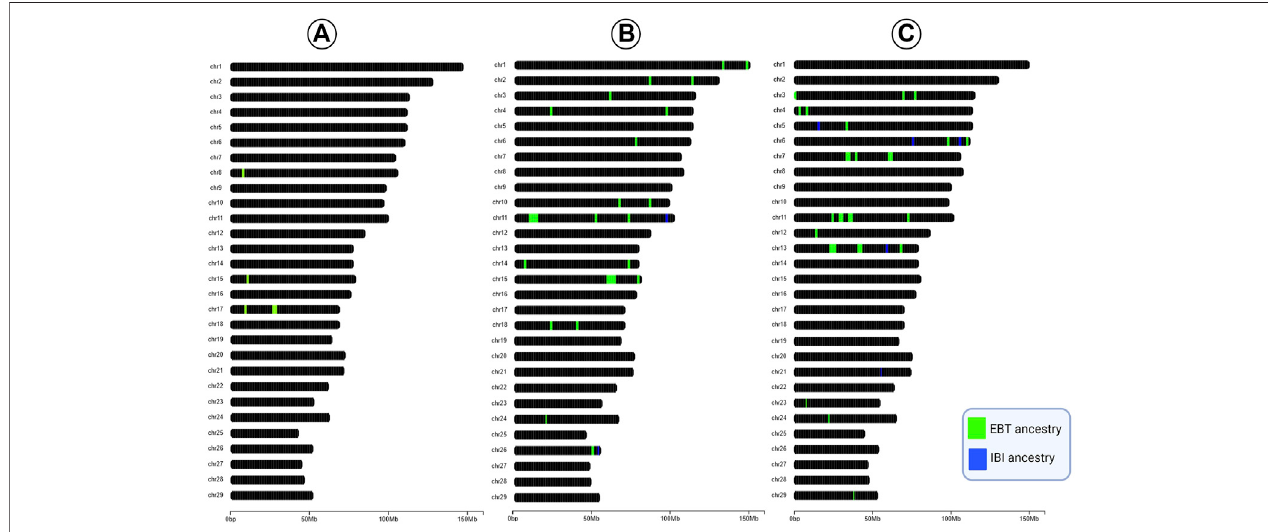
FIGURE4| Graphicalvisualizationofthecattlechromosomeswithregionsunderlyingsigni fi cantselectionandtheirorigininBeefmaster (A) ,Brangus (B) ,andSantaGertrudis (C)